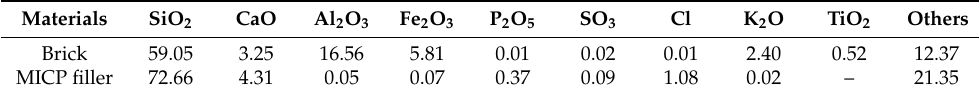
Figure 8. XRD results of the ancient bricks and MICP filler. Table 3. Results of the major elements (wt%) detected by XRF.